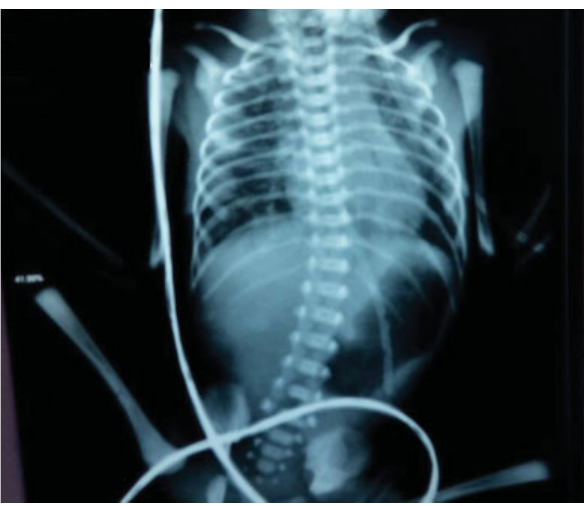
Fig. 1 PXR abdomen standing showing hugely dilated stomach and fi rst part of the duodenum (double bubble sign).